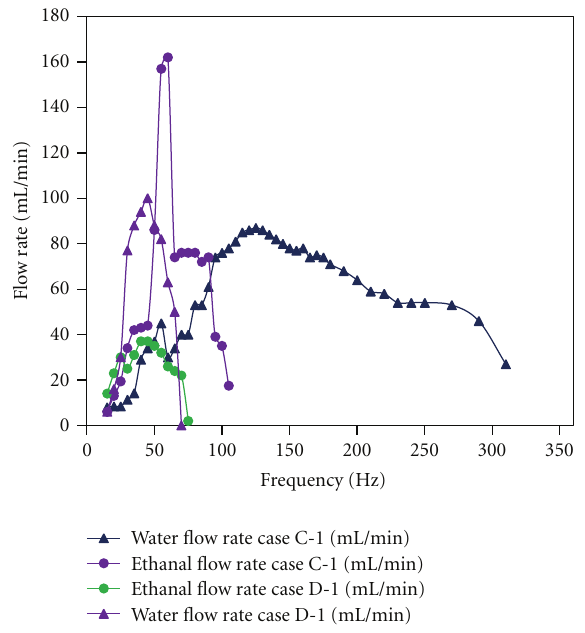
Figure 12: Measured flow rate under di ff erent frequency with dif- ferent chamber